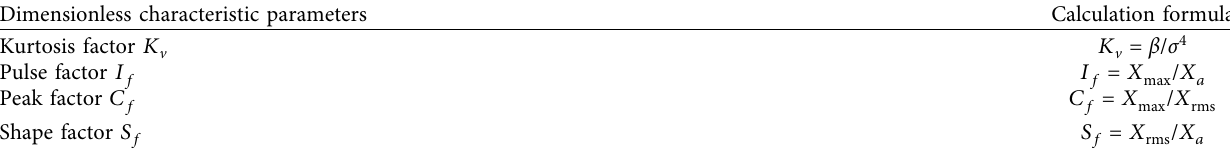
Table 3: Calculation formulas of dimensionless characteristic